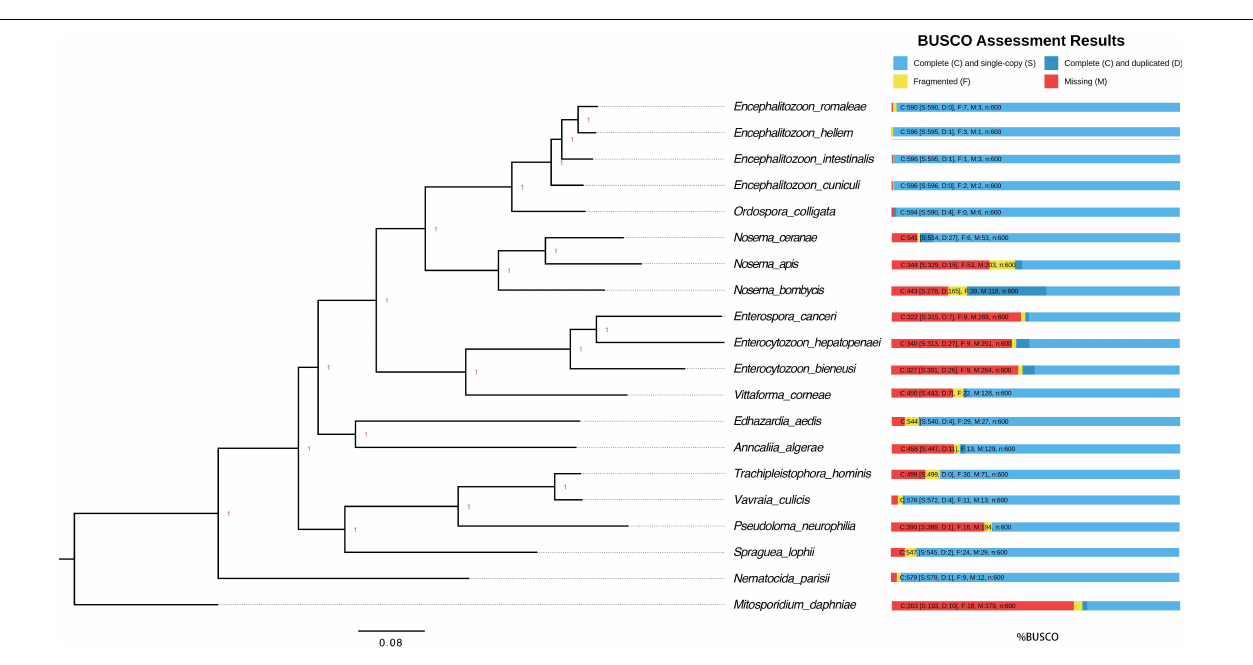
FIGURE 2 | Phylogenetic tree and estimated completeness of the genome of 20 microsporidian species. The phylogenic tree was constructed based on 48 BUSCO genes shared among the microsporidian species and M. daphniae is used to root the tree. All the branches were 100% supported. Overall, 90.2% of microsporidian BUSCOs (V10) were identified from N. ceranae . The studied species N. ceranae has been highlighted. The RNAi genes have been lost twice without reversal, which have been